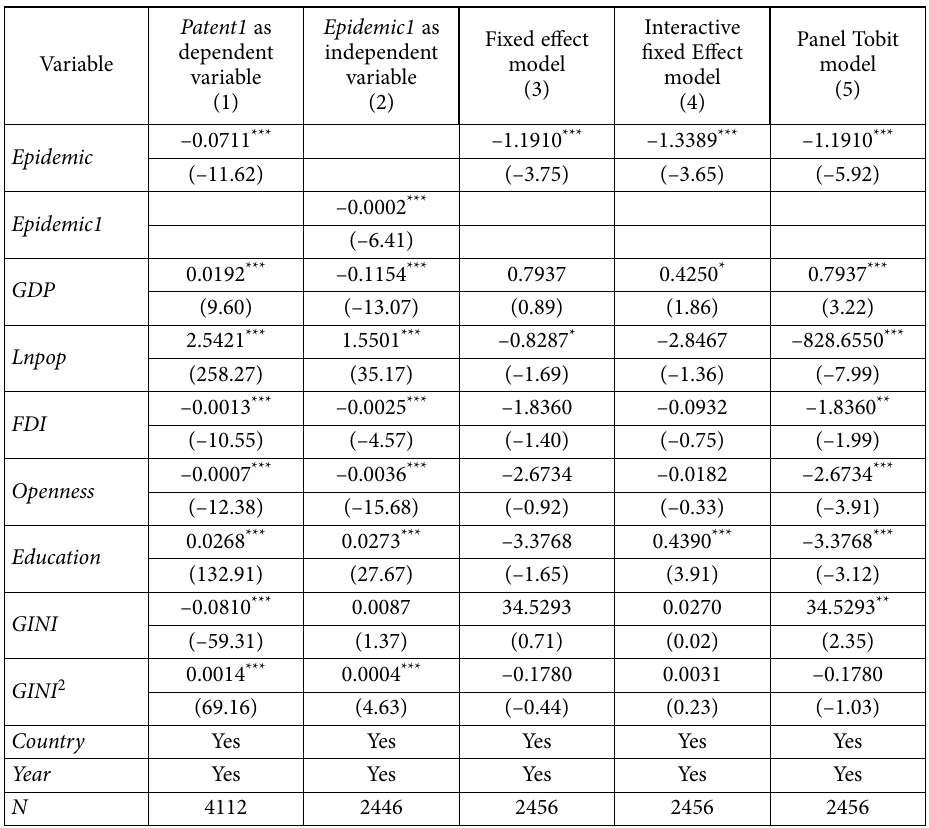
Table 6. Robustness tests: alternative variables and estimation